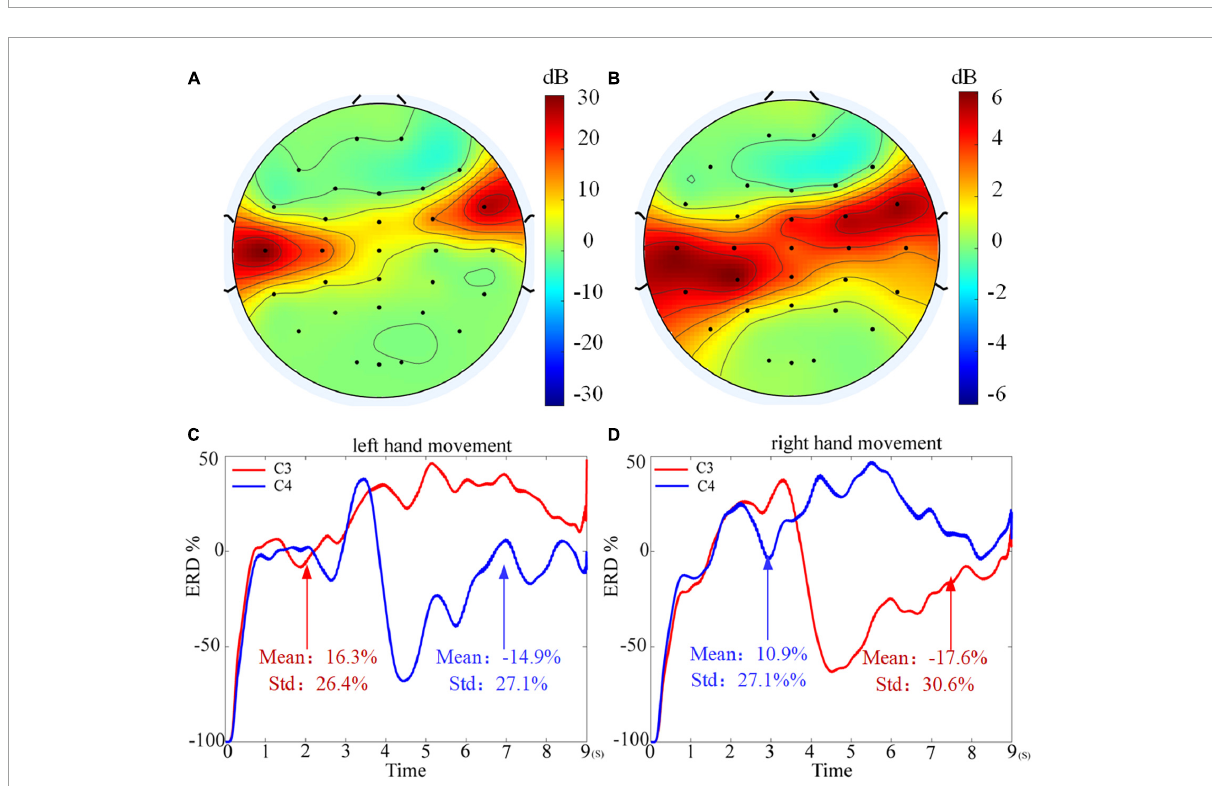
FIGURE8 Topographic map of weight distribution. (A) The result of table tennis group. (B) The result of non-table tennis group. (C) The event related desynchronization (ERD) analysis for the left hand motor imagination. (D) The ERD analysis for the right hand motor